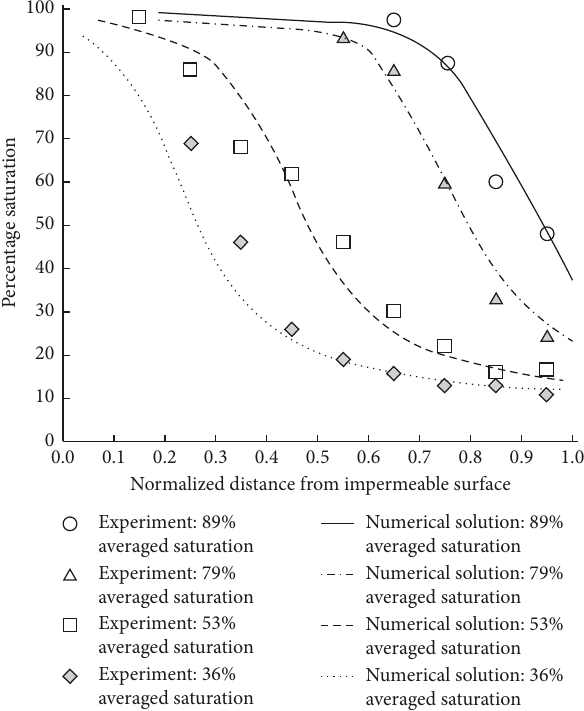
Figure 3: Comparison of numerical simulation and experimental values in drying of wet sand: saturation versus distance from the impermeable surface